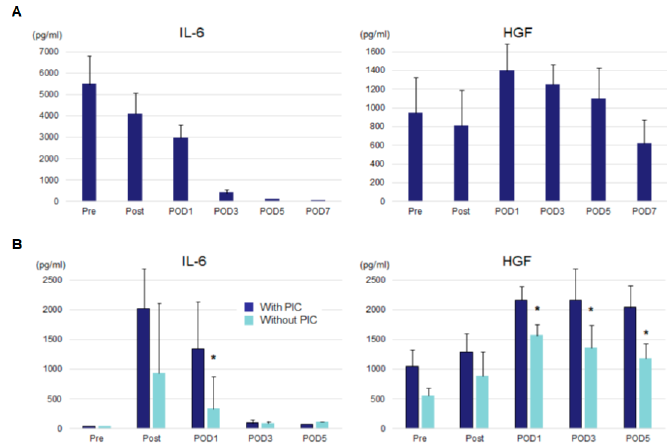
Figure 1. Serum IL-6 and HGF levels of patients with sepsis ( A ) and those who underwent esophagectomy ( B ). IL-6, interleukin-6; HGF: hepatocyte growth factor, POD: postoperative day, PICs: postoperative infectious complications. * p < 0.05 vs. patients with PIC.